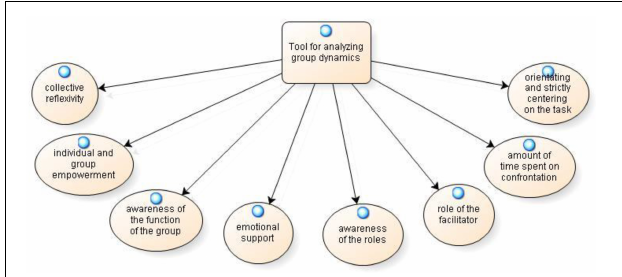
FIGURE 3 | Tool for analyzing group dynamics.